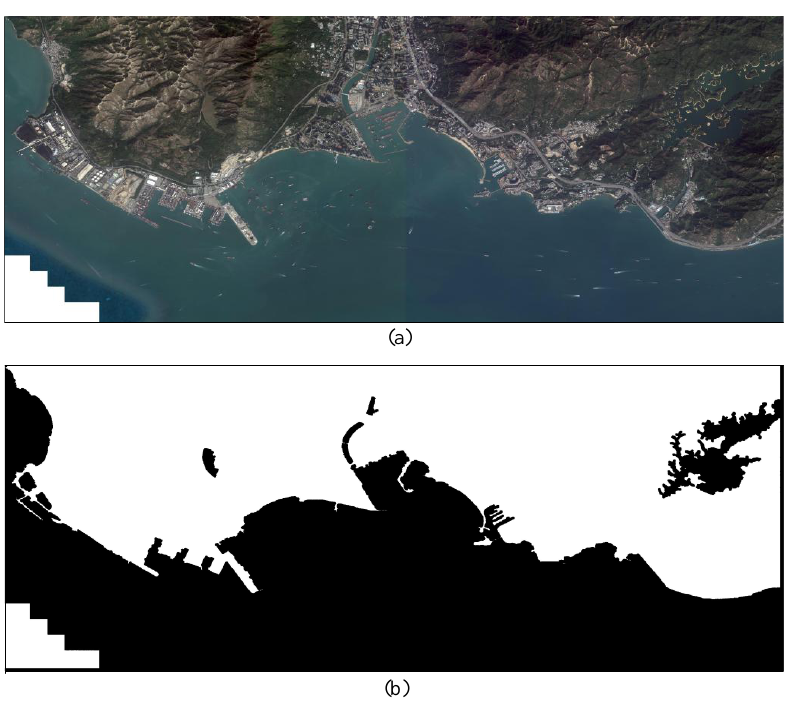
Figure 3. ( a ) The testing optical remote-sensing image IMAGE3. ( b ) The sea–land separation result corresponding to IMAGE3. It is a binary image, where the value of the position corresponding to the sea (or water) area is 0 (it is shown in black in the figure), and the position corresponding to the land region is 1(it is shown in white in the